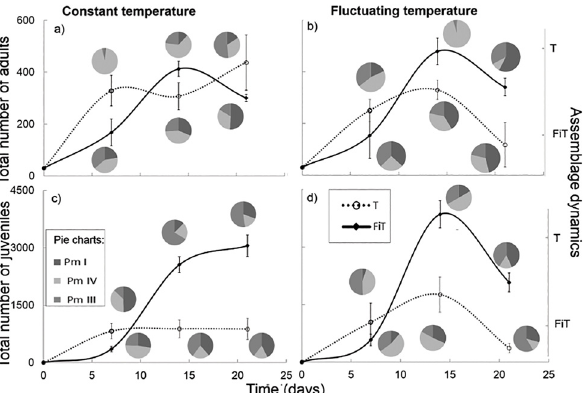
Fig 3. Total number of nematodes (adults: a + b, juveniles: c + d) over time in the different temperature treatments (constant temperature: a + c, fluctuating temperature: b + d) with assemblage dynamics at the different sampling times (three pie charts correspond with following time moments: 7, 14 and 21 days): upper pie charts for the T treatment (Pm I, Pm IV and Pm III with interspecific interactions), lower pie charts are the dynamics in the FiT treatment (Pm I, Pm IV and Pm III without interspecific interactions).